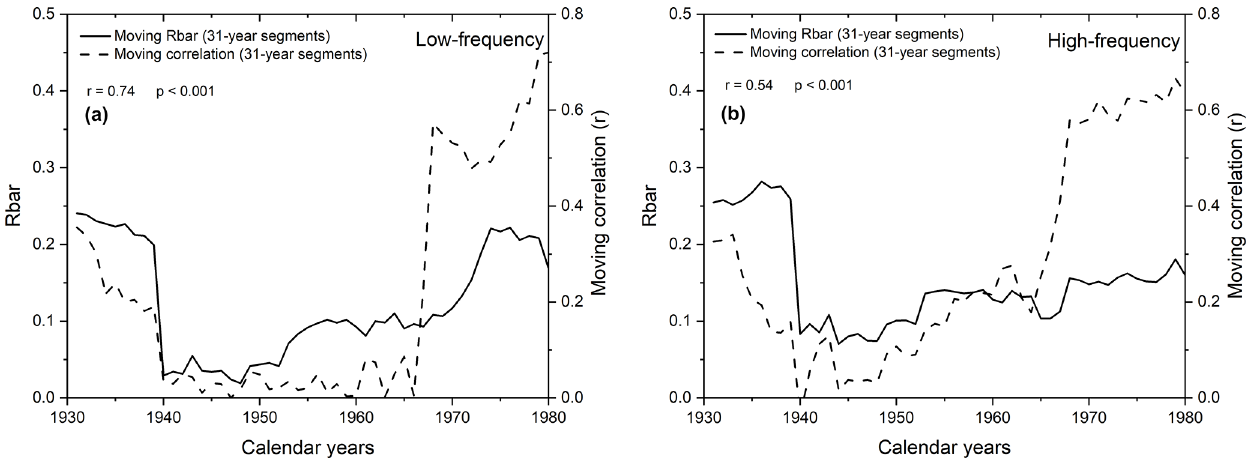
Figure 10. 31-year moving correlations between gridded instrumental and modelled summer temperatures using δ 13 C LM_RL values (a) and δ 13 C LM_high-frequency indices (b) (dashed lines) plotted together with the 31-year moving Rbar values of these data (solid lines).